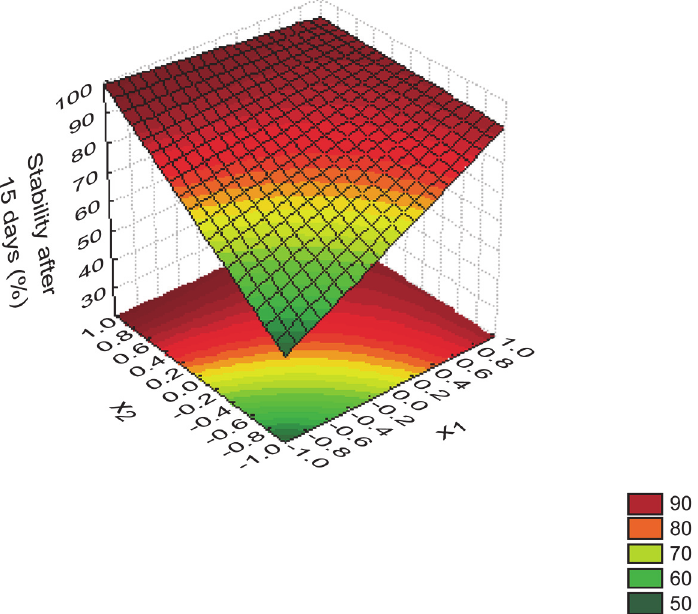
Fig 1. Response surface obtained from the model for stability after 15 days (%) (= 83 . 6 + 9 . 0 x 1 + 13 . 0 x 2 - 12,0 x 1 x 2 , where x 1 and x 2 are the normalized values of starch and Arabic gum concentrations).